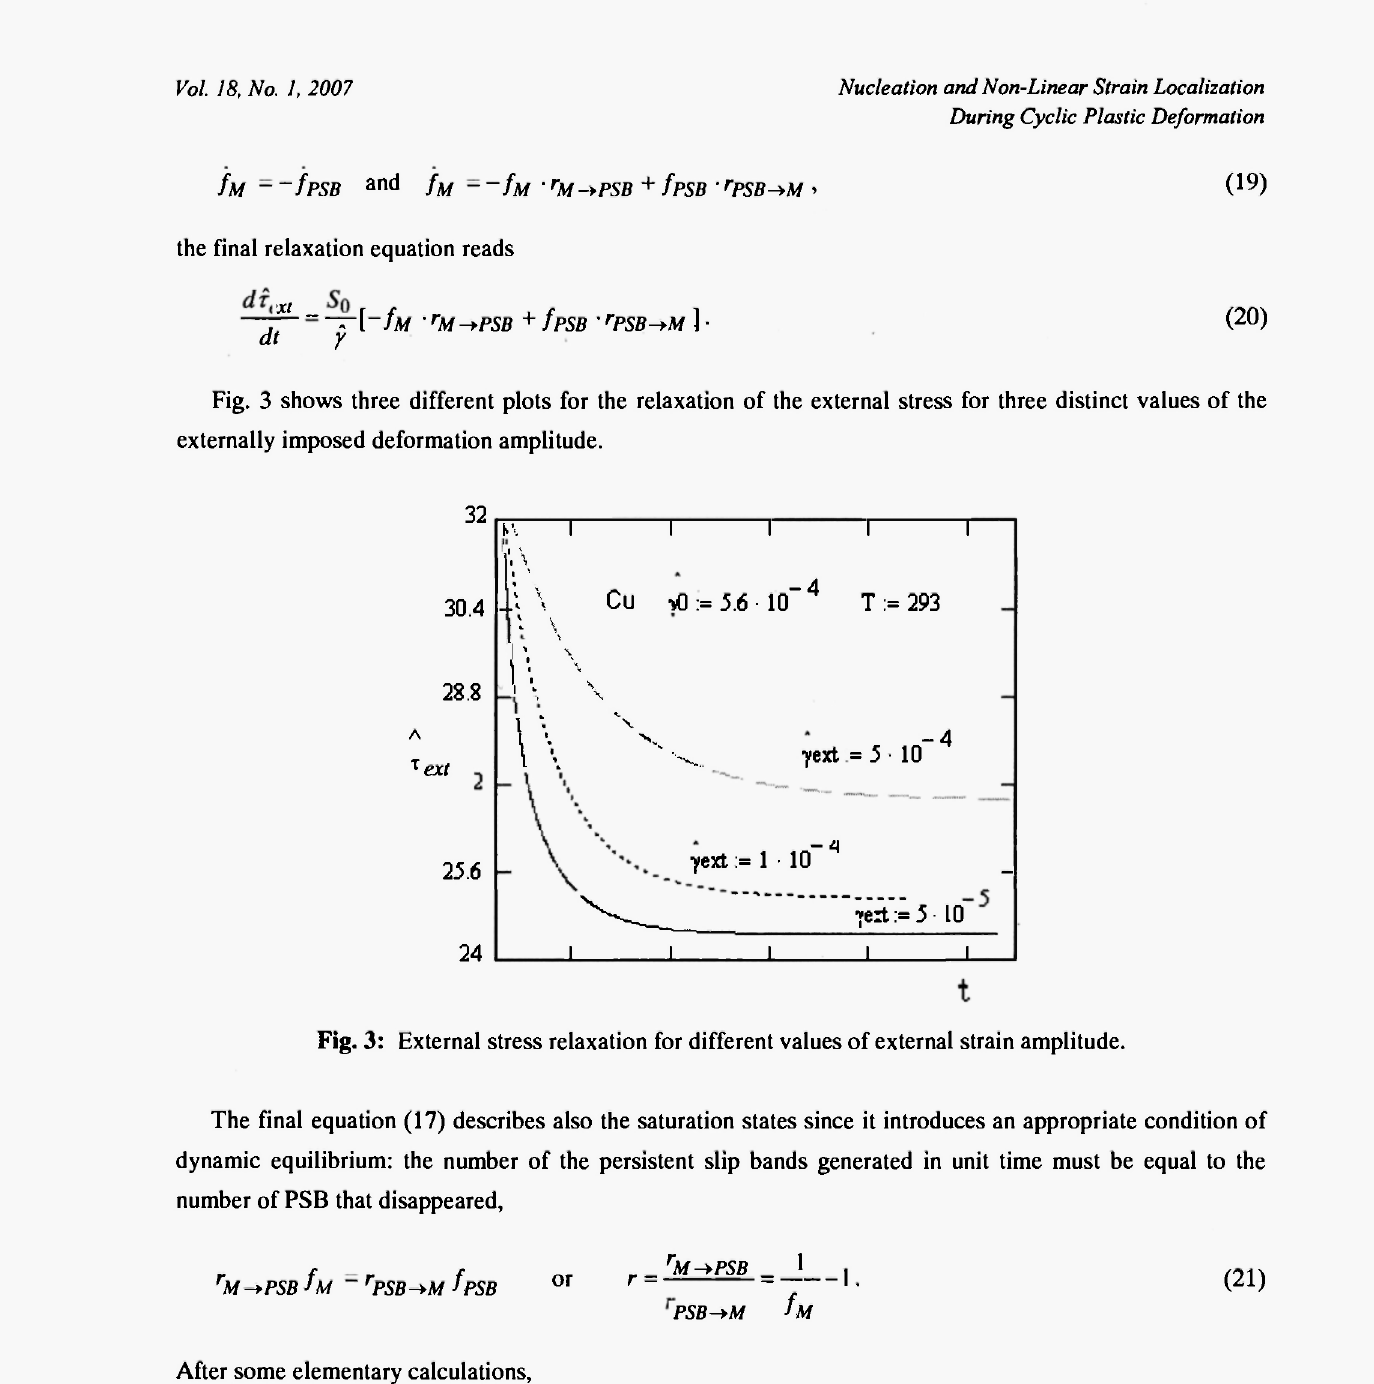
Fig. 3: External stress relaxation for different values of external strain